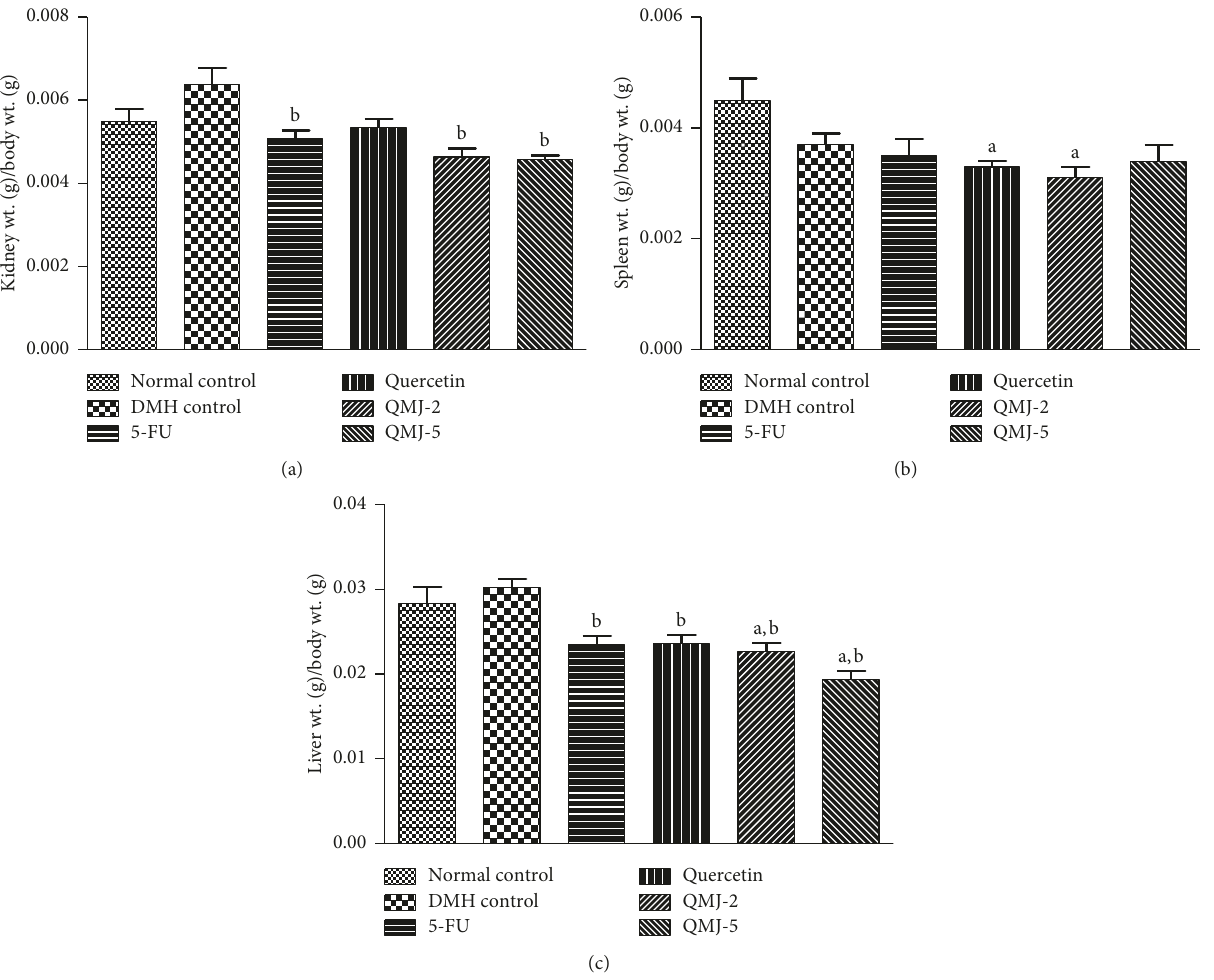
Figure 7: The bar graphs represent the effect of various treatments on the major organ index. All values are expressed as mean ± SEM of six animals. a p < 0 . 05 vs. normal control; b p < 0 . 05 vs. DMH control. (a) Kidney index; (b) spleen index; (c) liver